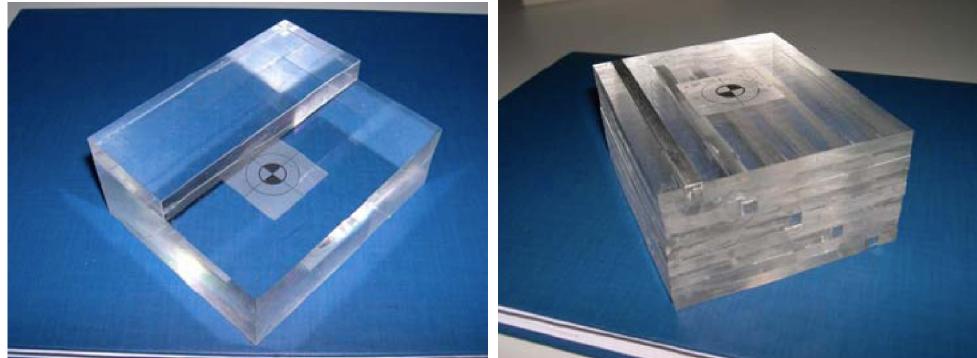
Figure 1. Phantom 1 ( left ) and Phantom 2 ( right ) used for proton radiography from [5].